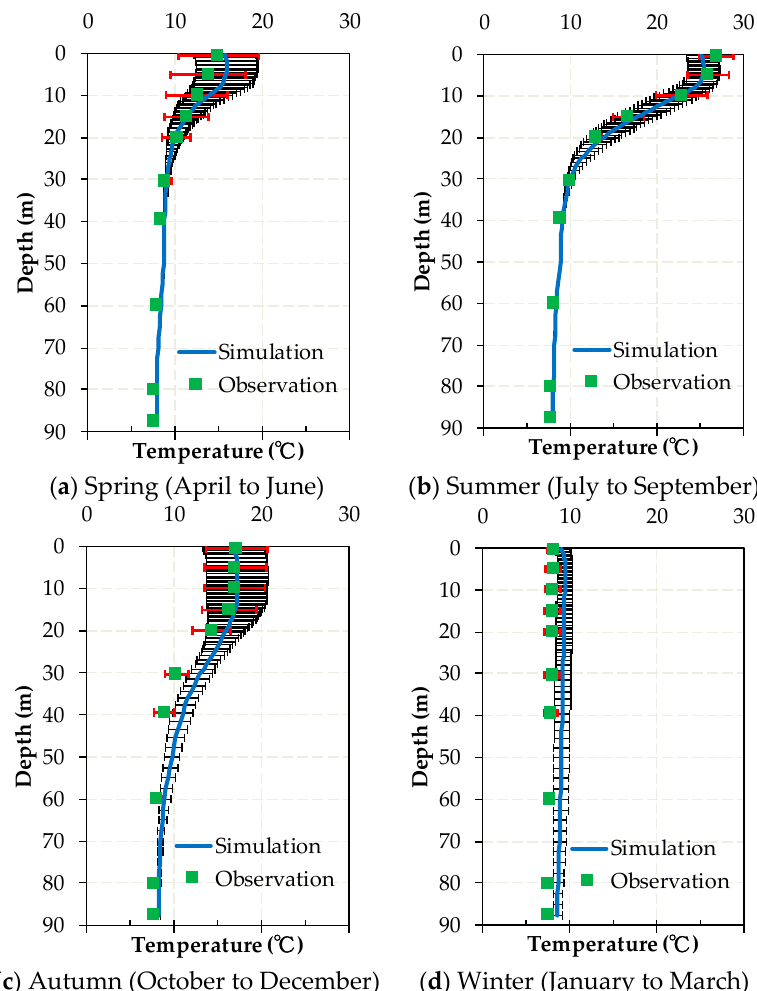
Figure 3. Vertical distribution of the mean value and standard deviation of the water temperature from 2007 to 2011 at the monitoring point in Imazu-oki in ( a ) April to June; ( b ) July to September; ( c ) October to December; and ( d ) January to March.